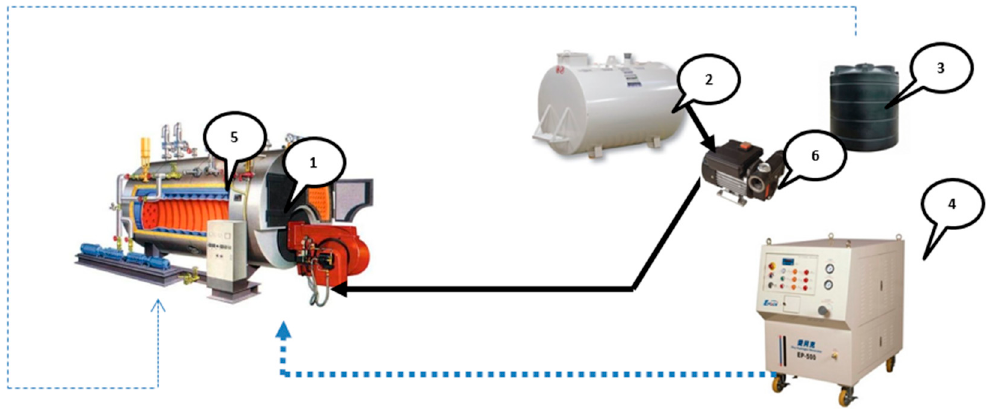
Figure 4. Test facility Table 1. Oil-fired boiler specification.